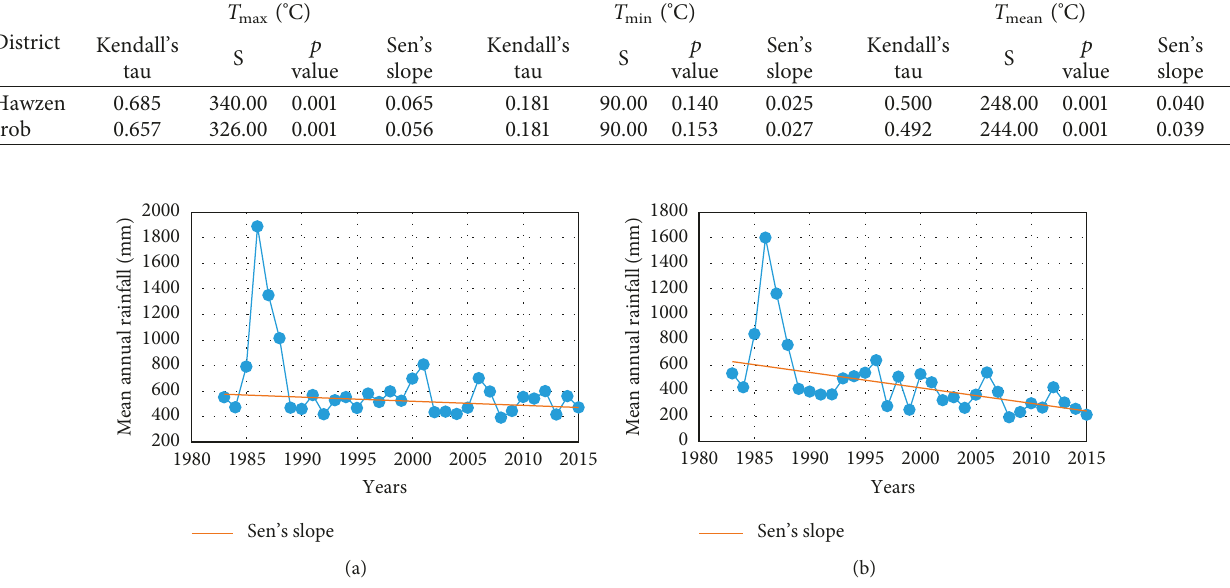
Figure 2: Mean annual rainfall trends for Hawzen (a) and Irob (b) districts during 1983–2015.